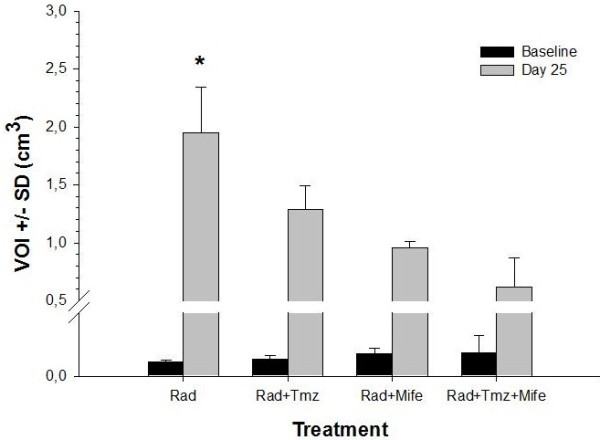
Metabolic activity of tumors, in terms of the VOI for the different experimental groups. (*) indicates a significant difference between the Rad group and the other experimental groups (n = 2).